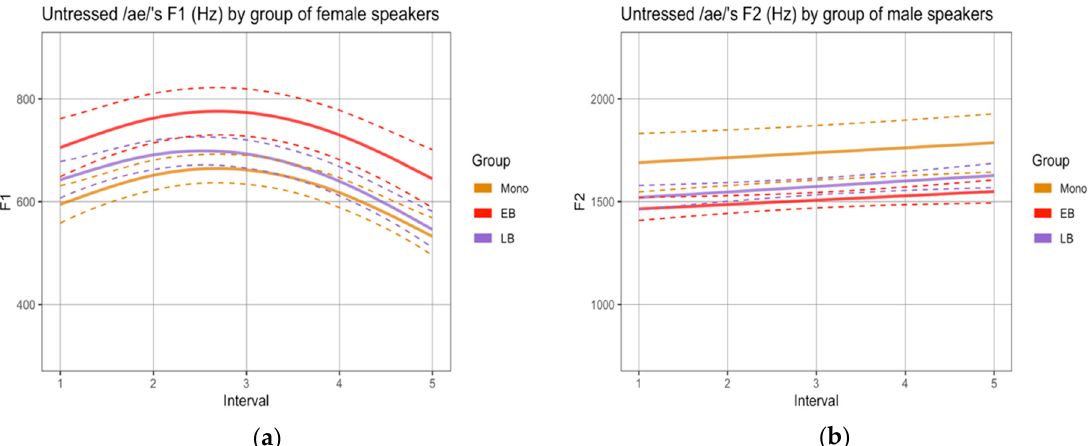
Figure 4. SSANOVAs for non-normalized formant trajectories across five intervals within the sequence / ae / produced by each group of speakers (M, EB, LB) in the narrative task: ( a ) F1 trajectories: female speakers; ( b ) F2 trajectories (male speakers).